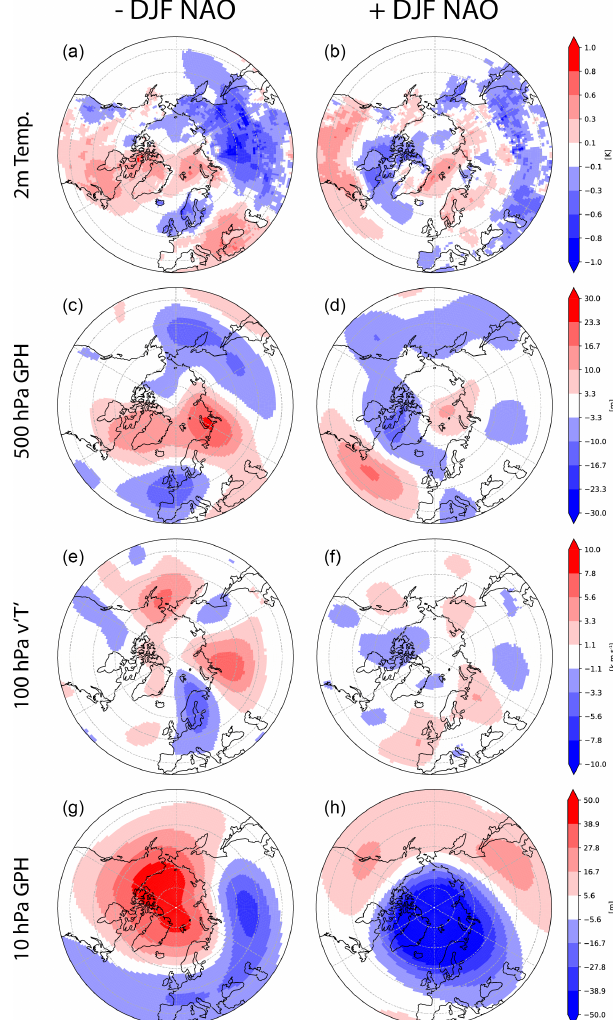
Figure 9. Climate anomaly composites of predicted December fields after which a positive snow dipole forcing preceded a neg- ative DJF NAO signal (a, c, e, g) or a positive DJF NAO signal (b, d, f, h) (selection of years based on Fig. 1d): (a, b) 2m temperature, (c, d) 500hPa geopotential heights, (e, f) 100hPa meridional eddy temperature flux and (g, h) 10hPa geopotential heights. Anomalies are based on ASF-20C EXP high–low snow dipole ensemble mean